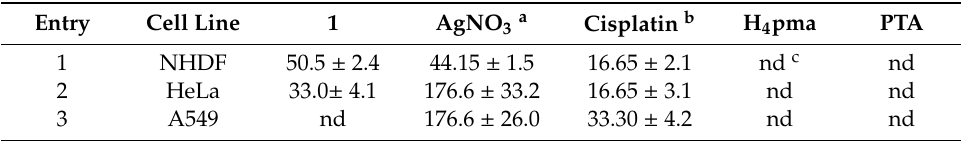
Table 2. Half maximal inhibitory concentration (IC 50 ) values ( µ